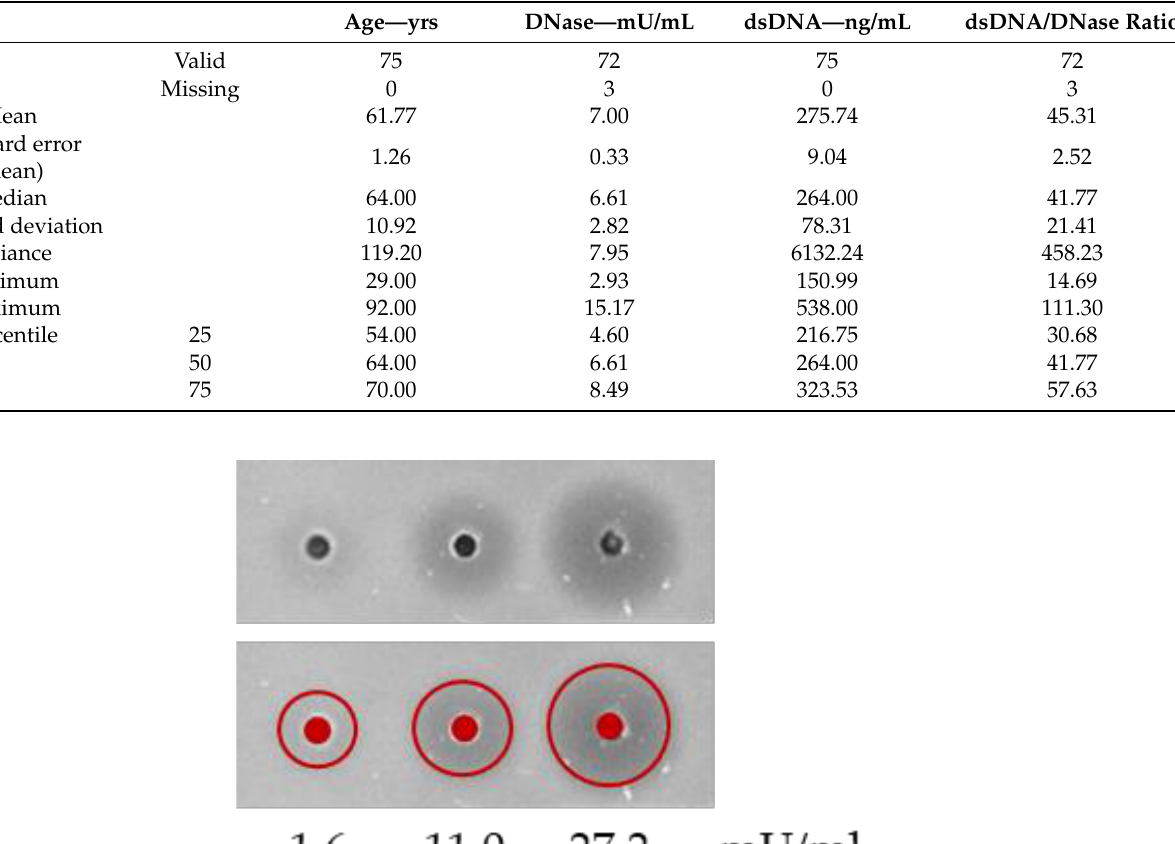
Table A1. Healthy controls. Abbreviations: yrs: years.